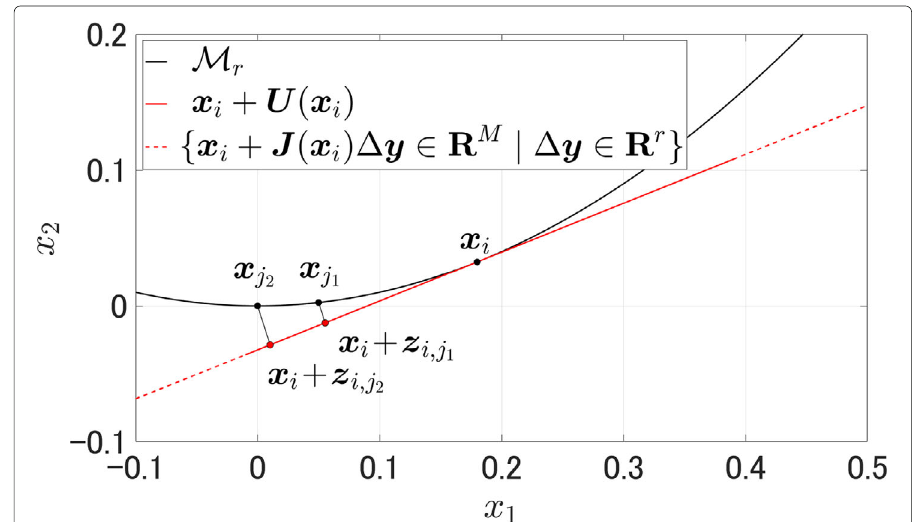
Fig. 1 An example of LDDM x = [ x 1 x 2 ] T = [ y y 2 ]